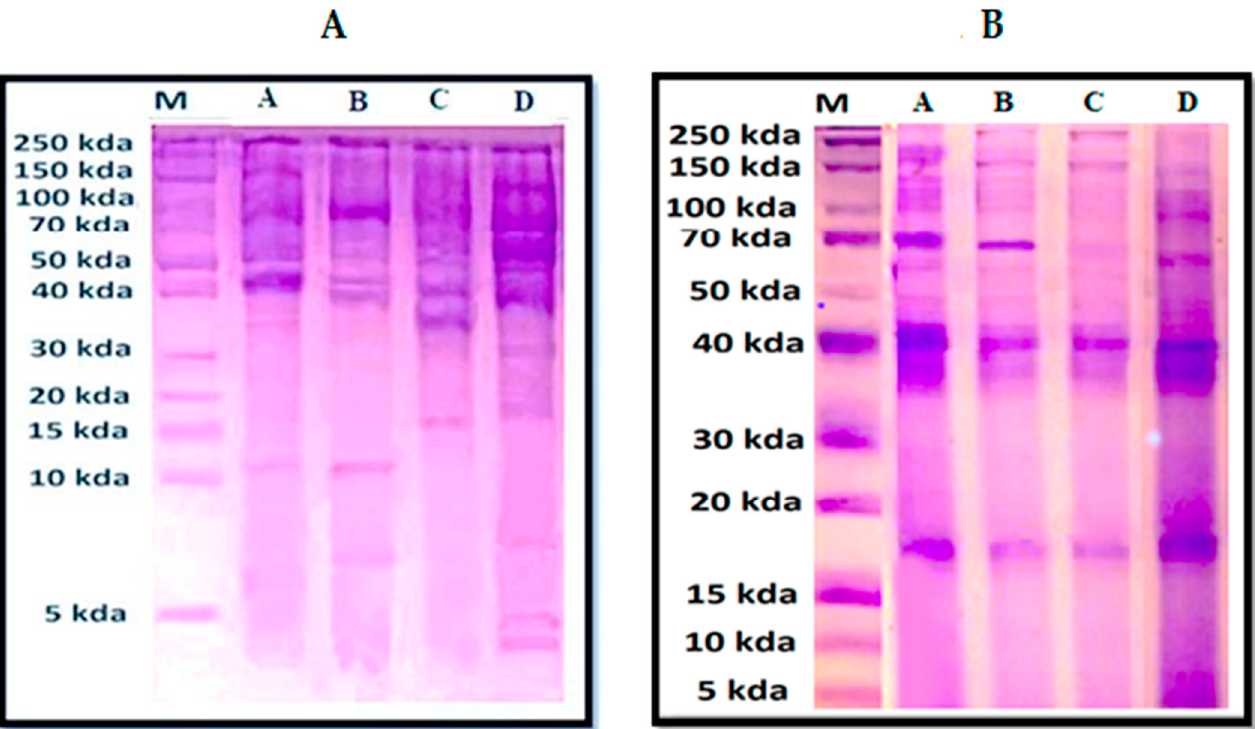
Figure 2. Photos of SDS-PAGE gels for honey bee hemolymph extracts dissolved in PBS ( A ) or DMSO ( B ) where ( A ): bees from Port Said, ( B ): bees from Ismailia governorate, ( C ): bees from Suez governorate, ( D ): bees from Saint Catherine. M : marker. The molecular weights of the proteins and their amounts are expressed by the color intensity of the protein bands.